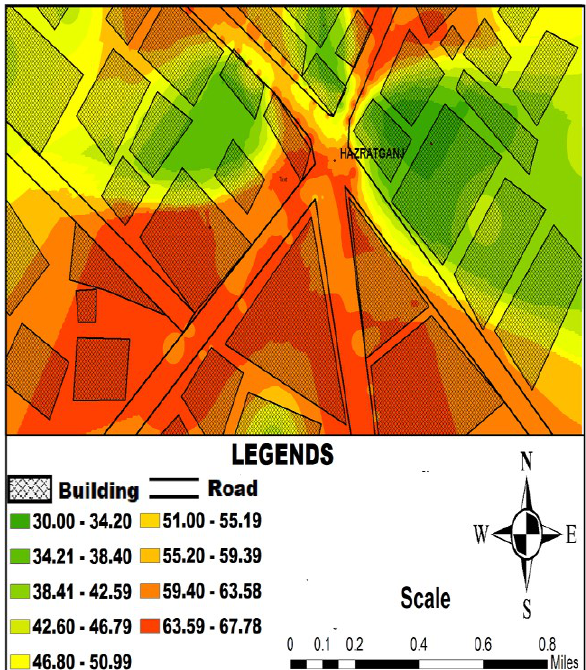
Figure 6. The Noise map of Hazratganj Chauraha evening slot with value variation is between 30.00 to 67.78. Barrier and distance attenuation is also calculated and